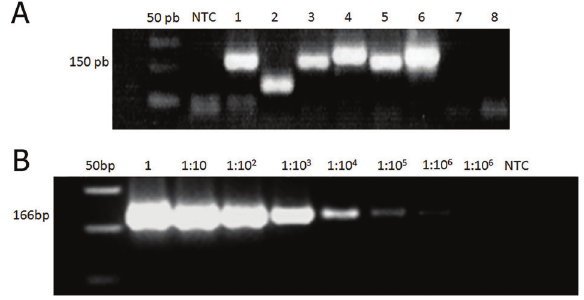
Figure 1. Nested PCR of bcl-2/IGH rearrangement. A , Ampli fi ca- tion products of NTC (no template control); 1 – 6: positive subjects; 7 and 8: negative subjects. B , Detection limits of bcl2 /IgH rear- rangement test. Karpas-422 cells were increasingly diluted with bcl2/IGH negative cells. Detection limit was 1:10 6 dilution. Table 1. Age and gender of the individuals evaluated for the t(14;18) translocation, according to ethnic